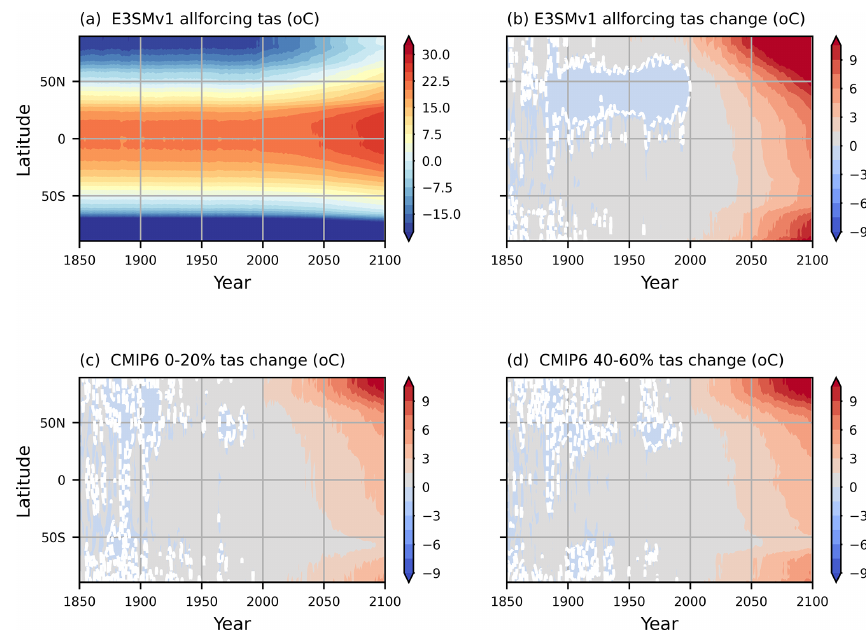
Figure 5. Time evolution of zonal mean (a) E3SMv1.0 annual ( T air ). Time evolution of the local changes in zonal mean T air with respect to 1850–1869 from the historical simulations and SSP5-8.5 simulations for (b) E3SMv1.0, (c) CMIP6 models within the 0–20th percentile range, and (d) CMIP6 models within the 40–60th percentile range based on Fig. 1c.